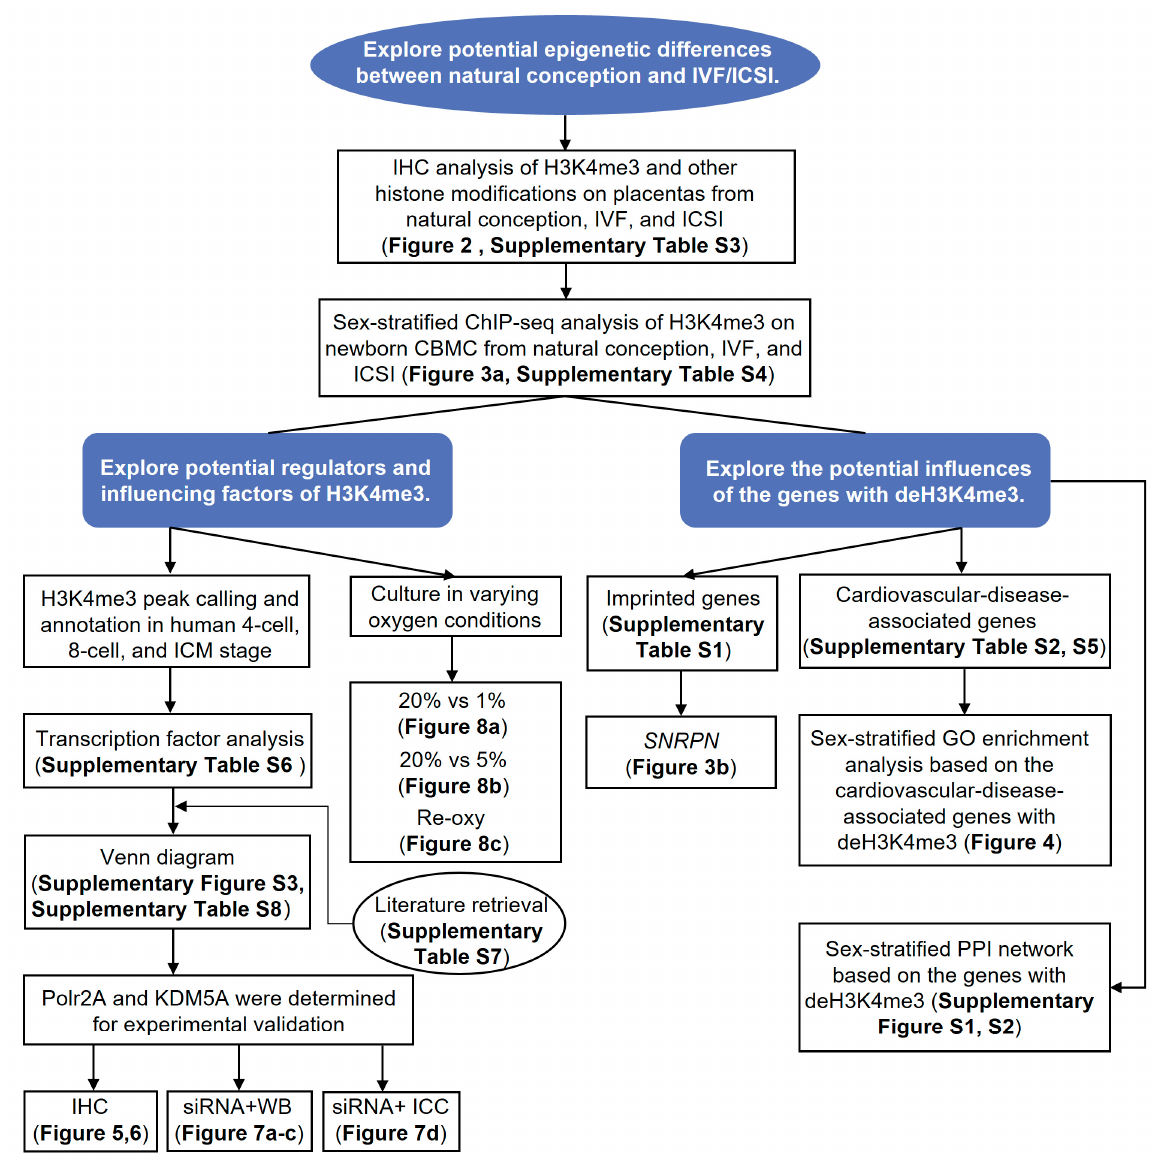
Figure 1. Flowchart of the study. IVF/ICSI, in vitro fertilization/intracytoplasmic sperm injection; IHC, immunohistochemistry; H3K4me3, tri-methylated histone H3 lysine-4; ChIP-seq, ChIP-sequence; CBMC, cord blood mononuclear cell; deH3K4me3, differentially enriched H3K4me3; ICM, inner cell mass; Polr2A, RNA polymerase II subunit A; KDM5A, lysine demethylase 5A; siRNA, small interfering RNA; WB, western blot; ICC, immunocytochemistry; ‘Re-oxy’ referred to intermittent hyperoxia exposure (5% O 2 8 h + 20% O 2 16 h + 5% O 2 8 h); SNRPN , small nuclear ribonucleoprotein polypeptide N ; GO, gene ontology; PPI, protein-protein interaction.